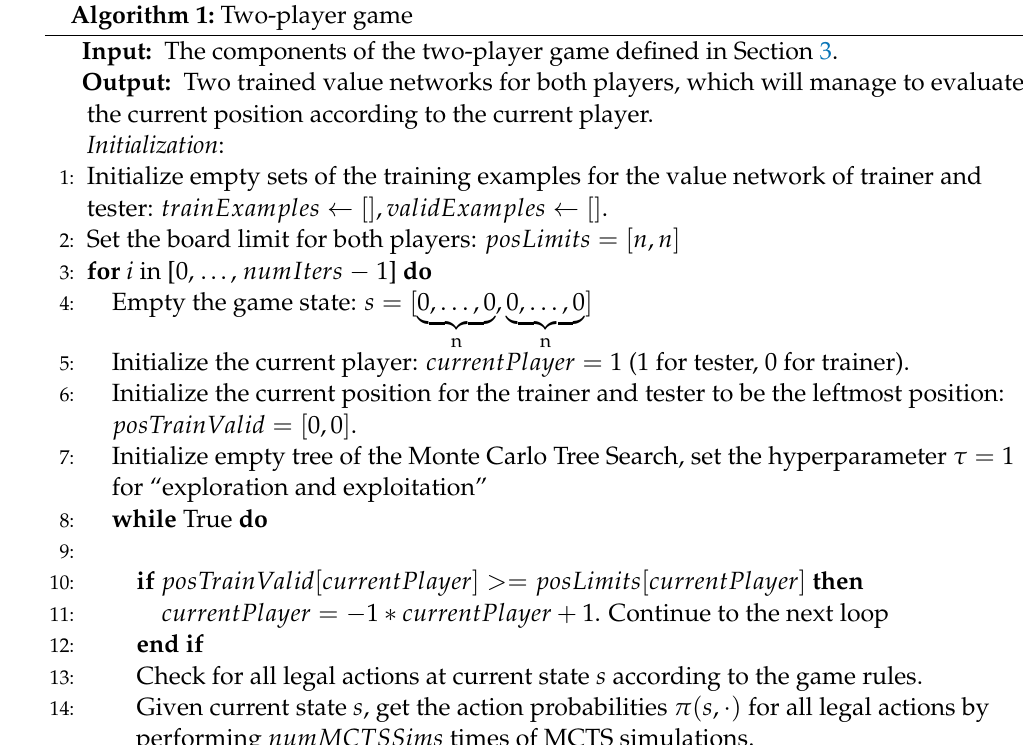
Algorithm 1: Two-player